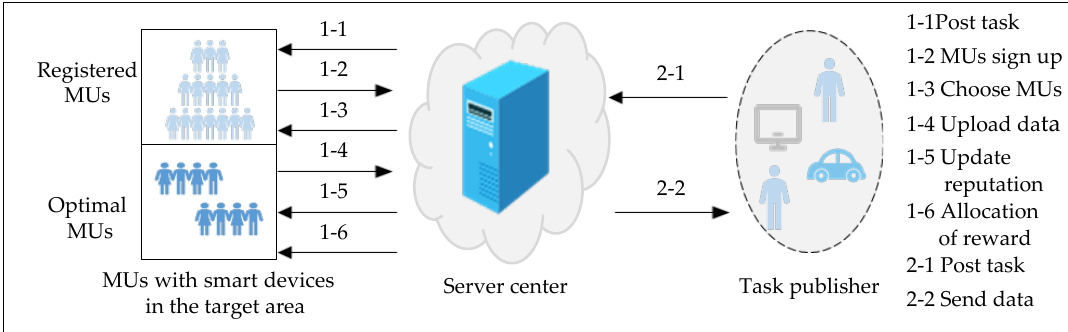
Figure 1. System model of crowdsensing.